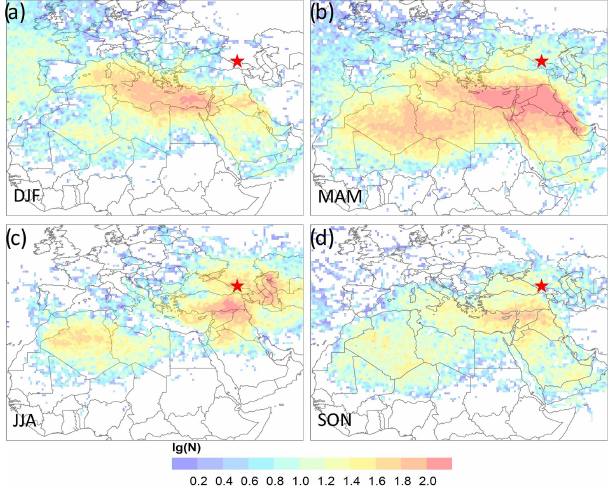
Figure 3. NOAA HYSPLIT_4 10d backward trajectories density plots for the period 1948–2013 for December–February (a) , March– May (b) , June–August (c) , and September–November (d) using NCEP/NCAR Reanalysis. Trajectories were run every 6h. Only backward trajectories within the boundary layer were